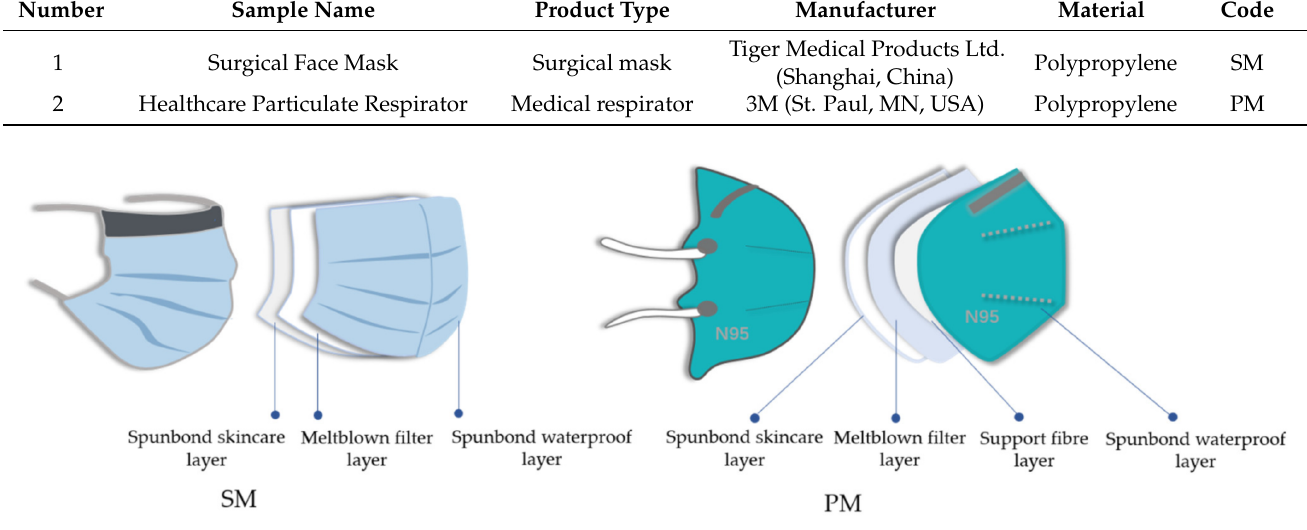
Table 1. Basic characteristics of two types of masks.